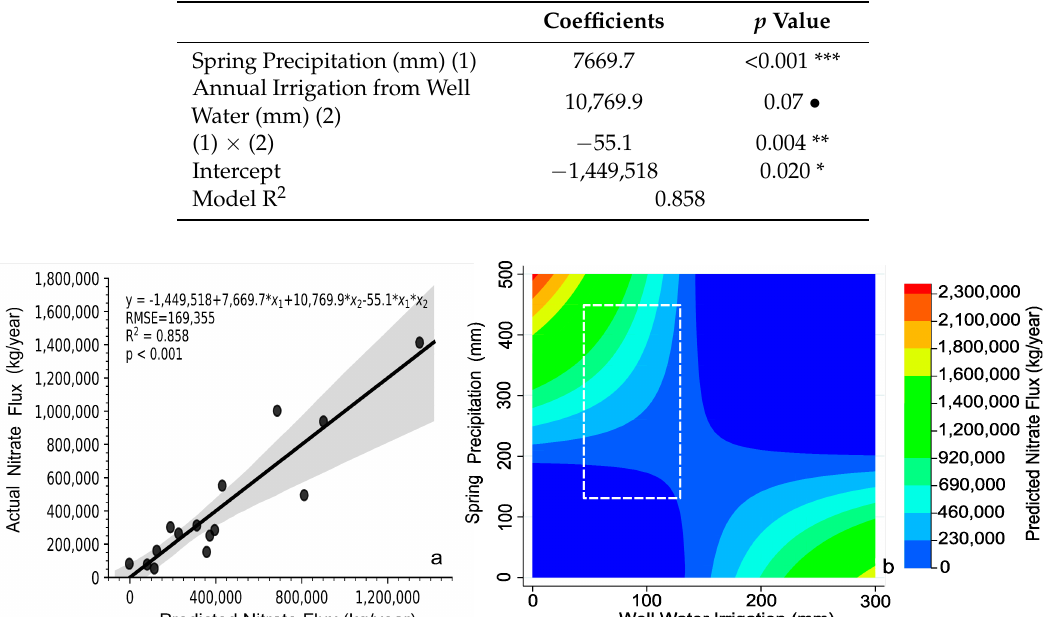
Figure 7. ( a ) Comparison of annual nitrate flux predicted by the multilinear regression model (spring precipitation, well water irrigation and their interaction) and measured; ( b ) Contour plot of the model as functions of spring precipitation and annual well irrigation. The dashed white box denotes the ranges of values of the two variables used in regression.